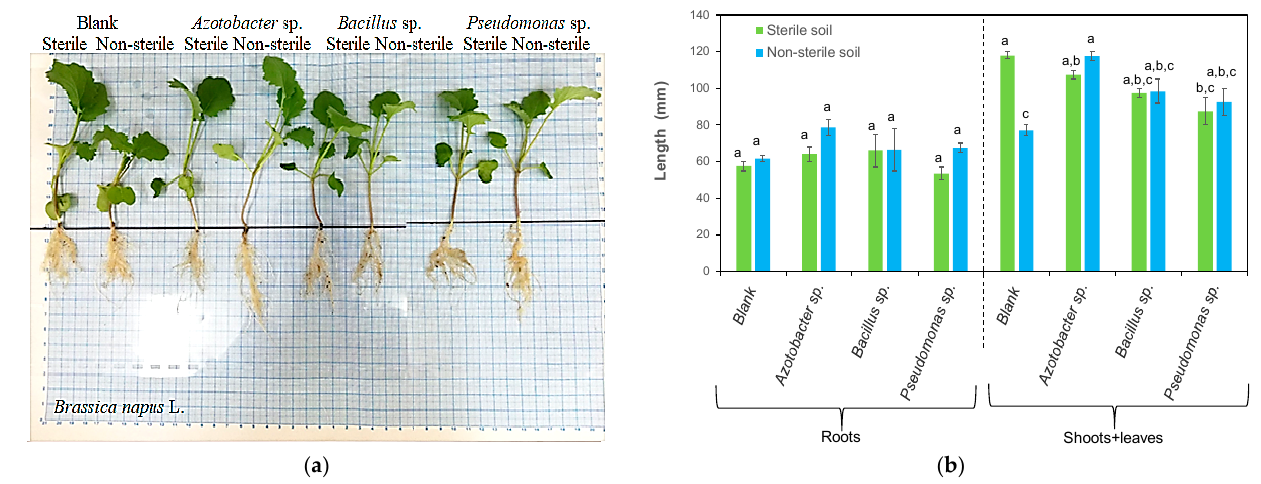
Figure 4. Effects of Azotobacter , Bacillus and Pseudomonas species on Brassica napus L.: ( a ) visual aspect of plants and ( b ) the root and shoot/leaf length (error bars represent the experimental error; means that do not share a letter are significantly different according to the Tukey’s HSD test).